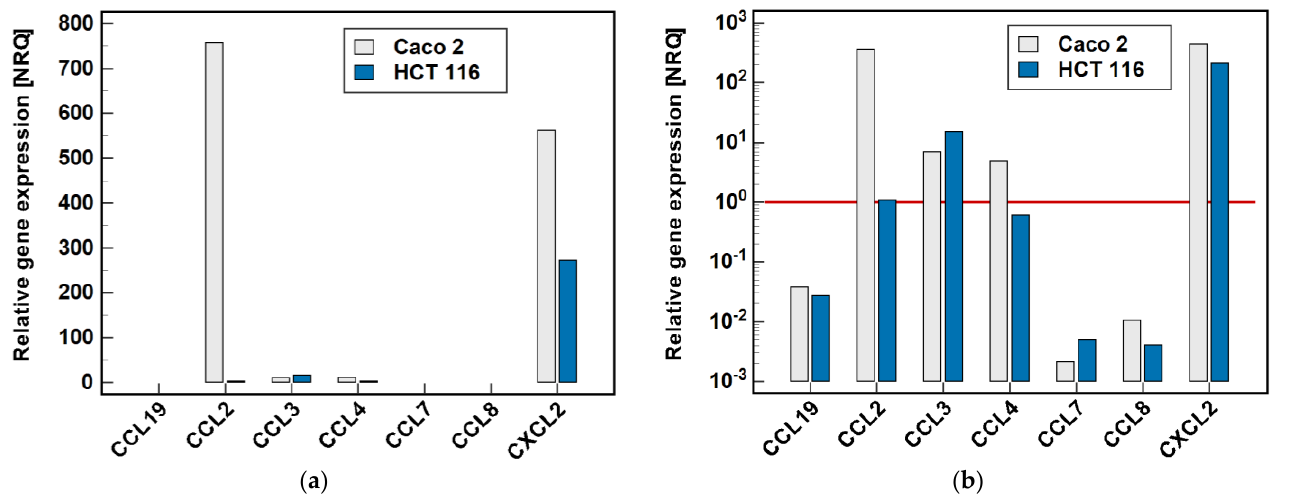
Figure 2. Relative expression of MCPs and MIPs in the Caco-2 and HCT 116 colonic adenocarcinoma cell lines: ( a ) non- logarithmized data; ( b ) data presented on a log-scale. The data are presented as normalized relative quantities (NRQ), normalized against GAPDH expression and expressed in relation to the geometric mean of global expression of all of the genes across both cell lines. The gene expression was analyzed in the control (untreated) cells, n = 9 per line. The red horizontal line represents the global mean expression.